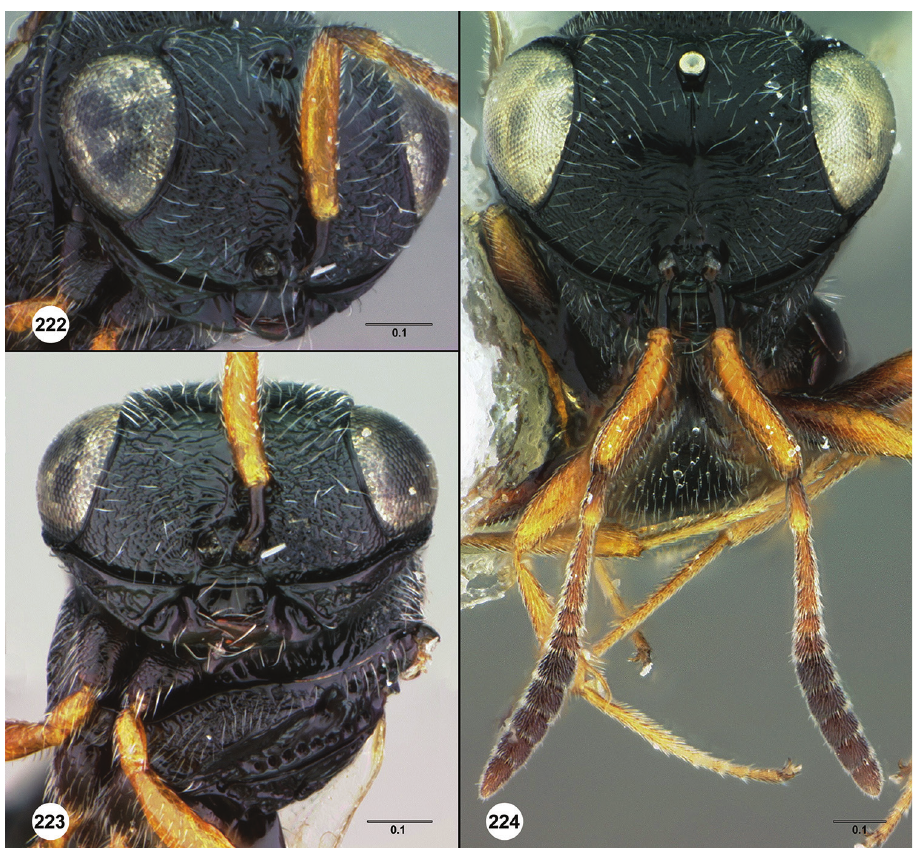
Figures 222–224. T. yamagishii 222 female holotype (Type No. 2221 Kyushu Univ.), head, anterior view 223 female holotype (Type No. 2221 Kyushu Univ.), head and mesosoma, anteroventral view 224 female (USNMENT00896189), head and antennae, anterior view. Scale bars in millimeters. present as line of foveae. Paracoxal sulcus in ventral half of metapleuron: indistinguish- able from sculpture to absent. Anteroventral extension of metapleuron: extending to base of mesocoxa. Metapleural epicoxal sulcus: absent or indistinguishable from sculp- ture. Mesoscutal humeral sulcus: present as a simple furrow. Median mesoscutal carina: absent. Macrosculpture of mesoscutum: reticulate anteriorly, becoming longitudinally strigose posteriorly. Pattern of mesoscutal microsculpture: uniform throughout. Mes- oscutal suprahumeral sulcus: comprised of cells. Length of mesoscutal suprahumeral sulcus: about half the length of anterolateral edge of mesoscutum. Notaulus: absent. Median protuberance on anterior margin of mesoscutellum: absent. Shape of dorsal margin of anterior lobe of axillar crescent: round. Sculpture of anterior lobe of axillar crescent: dorsoventrally strigose. Posterodorsal margin of axillular carina: pointed. Area bounded by axillar crescent: smooth. Macrosculpture of mesoscutellum: longitudi- nally strigose medially, rugulose laterally. Microsculpture on mesoscutellum: